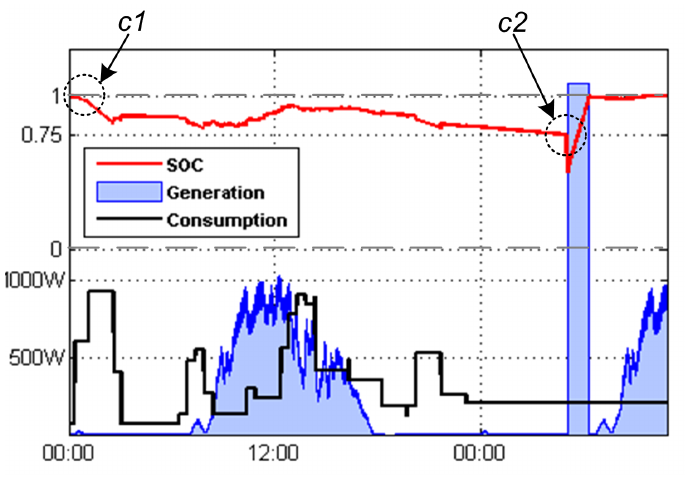
Figure 8. Example of day with low generation and considerable demand.